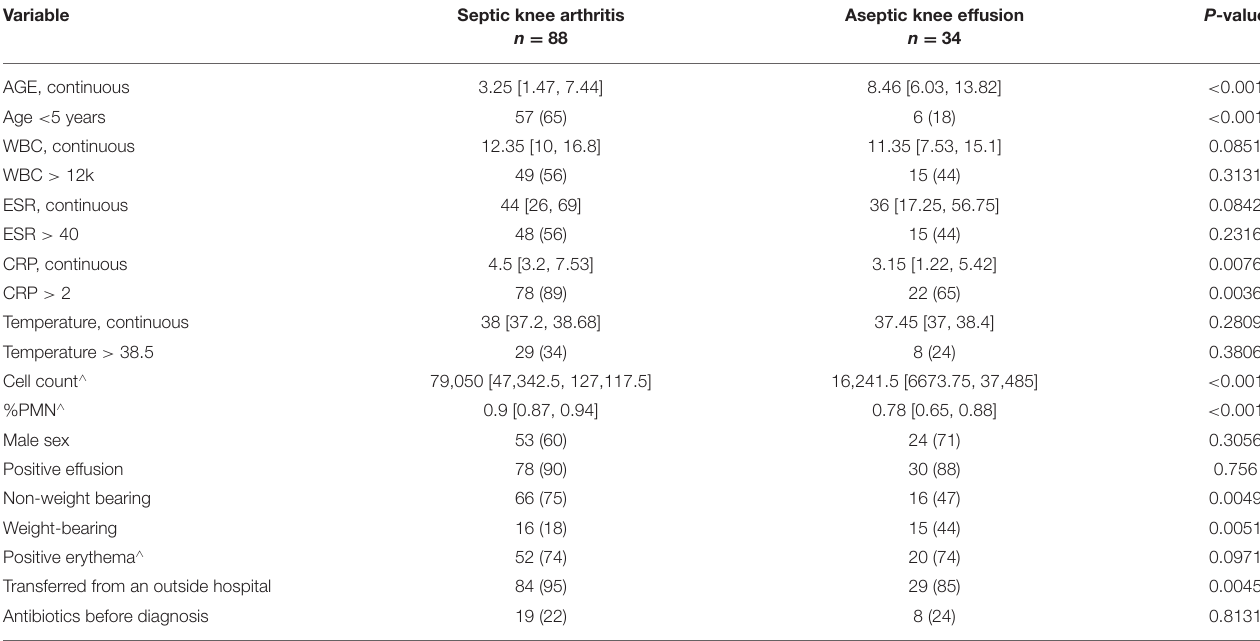
TABLE 1 | Comparison of septic knee vs. aseptic knee, continuous